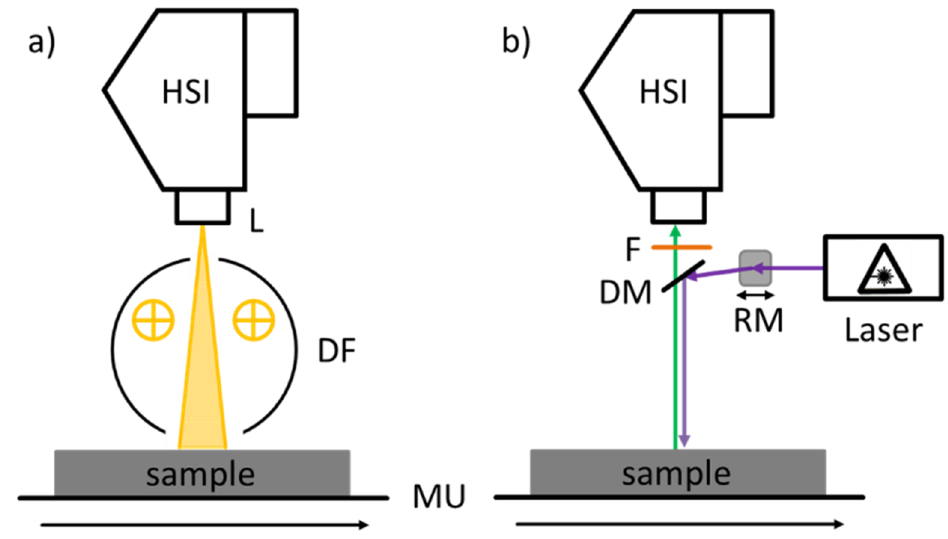
Figure 2. ( a ) Schematic representation of the VNIR HSI system and ( b ) schematic representation of the Laser HSI system. HSI: VNIR HSI camera. L: Lens. DF: Diffuse halogen illumination. F: Long pass filter. DM: Dichroic mirror. RM: Rotating mirror. MU: Motion unit.